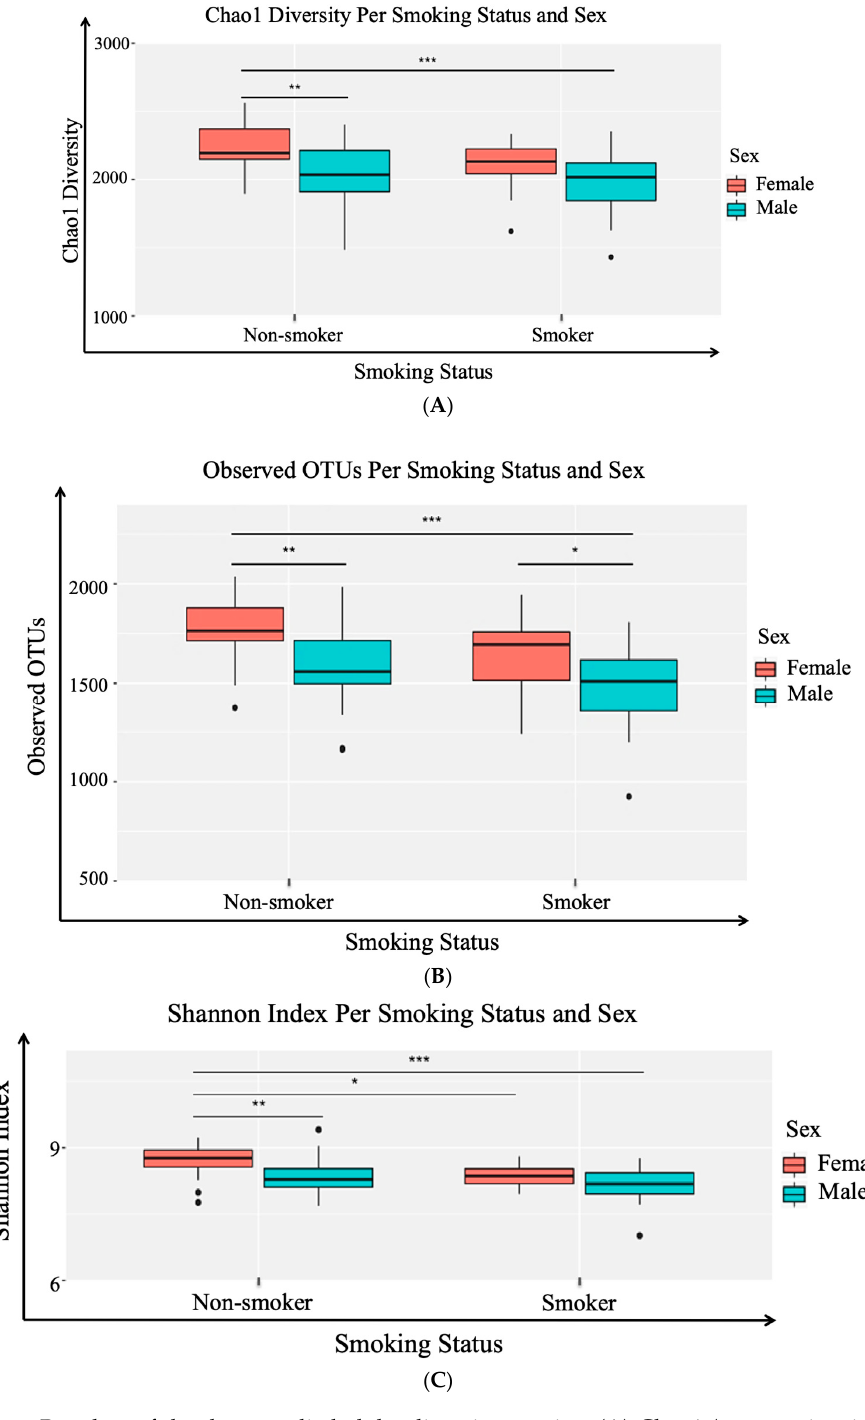
Figure 2. Boxplots of the three studied alpha diversity metrics: ( A ) Chao1 (community richness), ( B ) observed OTUs (community uniqueness), and ( C ) Shannon (community evenness or entropy). Red boxplots represent females and green boxplots represent males. Statistically significant differences were determined using analysis of variance with alpha diversity as the response variable, and smoking status and sex as crossed predictor variables, with Tukey’s HSD for group-specific differences. * Statistically significant at adjusted ( p -value < 0.05), ** Statistically significant at adjusted ( p -value < 0.01) and *** Statistically significant at adjusted ( p -value <